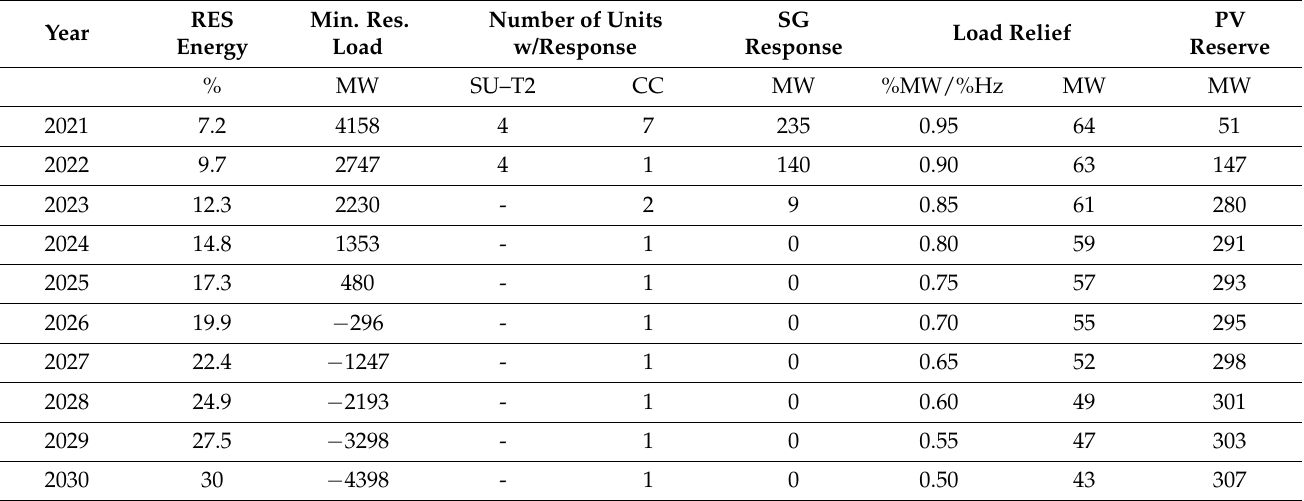
Table 3. Required Reserve from PV Facilities, Case 2–30%